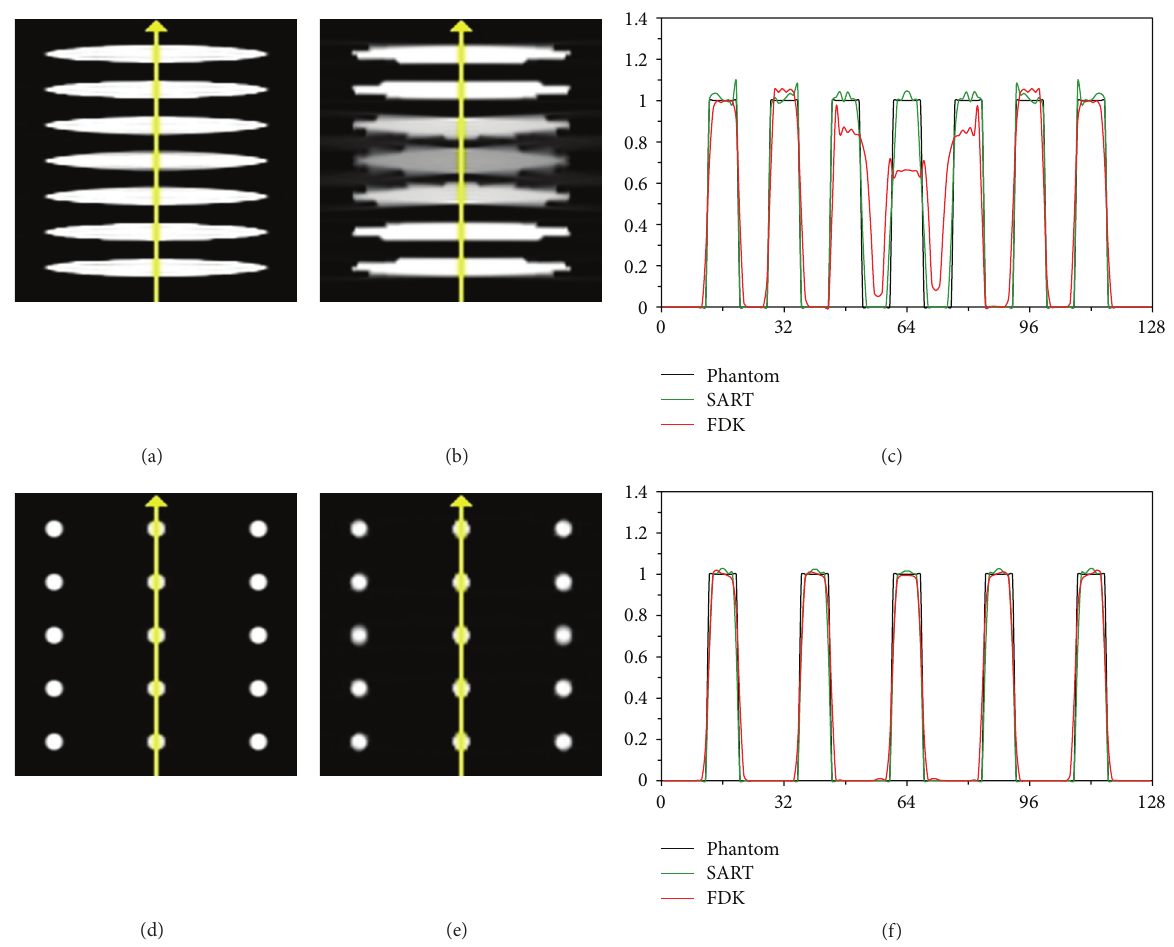
Figure 12: Transverse images reconstructed using the (a) FBP algorithm on data generated using fan-beam geometry and the (b) SART algorithm using the dual-source dual-detector geometry. Coronal images were also reconstructed using the (c) FBP and (d) SART